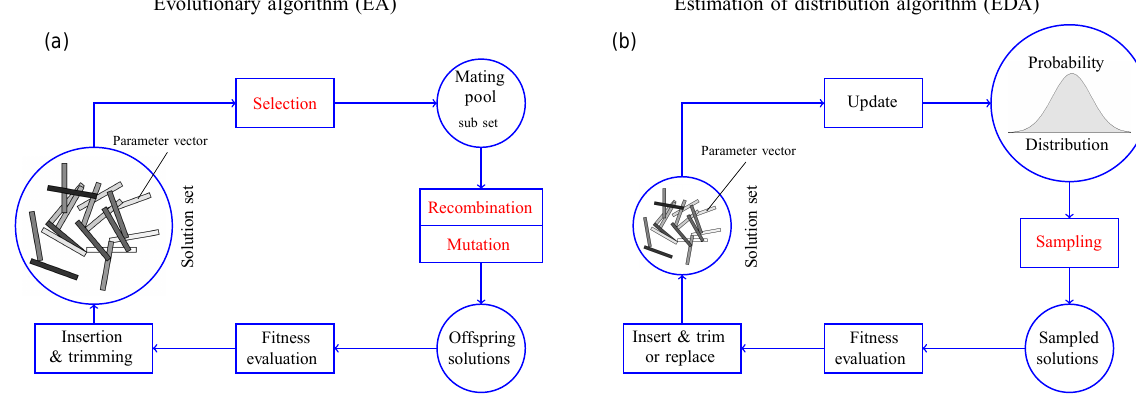
Figure 1. A general EA (left) and EDA (right) schematic. Cycles represent sets of solutions (vectors of BGC parameters in our case) or an explicit probability distribution from which new solutions can be drawn. Rectangle symbols depict operations. Operations displayed in red font depend on random decisions. EA: a set of candidate solutions (population) is iteratively updated. In each generation, candidate solutions compete to form a mating pool which is realized by a random selection operator. Offspring solutions are produced by recombining mates and/or introducing some mutation. Finally, there is a fitness based insertion back into the population, which is usually trimmed to a predefined population size. The random operators selection, recombination, and mutation imply an implicit probability distribution on the search space with respect to which solutions are likely to appear in the next generation. EDA: candidate solutions of the current iteration’s population are used to update an explicit probability distribution such that the likelihood to sample good solutions increases. New candidate solutions are directly sampled from the probability distribution. Usually, the realization of the probability distribution update ensures that information of former solutions fades out slowly, resisting for several iterations. Therefore, the population may be smaller as an EA population and even be replaced with the entire set of new samples, which is the case for the CMA-ES algorithm we